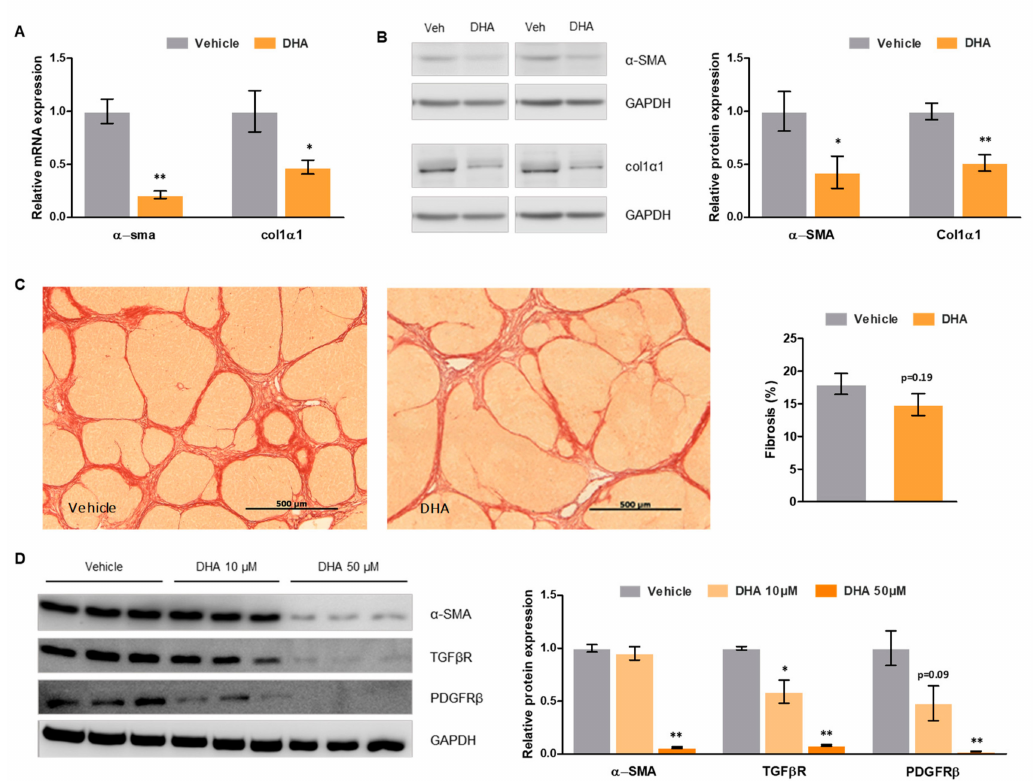
Figure 3. E ff ects of DHA on hepatic stellate cell (HSC) phenotype and fibrosis. ( A ) α -SMA and collagen-1 α 1 relative mRNA expression in total liver tissue from cirrhotic rats treated with DHA or vehicle, normalized to GAPDH. ( B ) α -SMA and collagen-1 α 1 relative protein expression in total liver tissue from cirrhotic rats treated with DHA or vehicle, normalized to GAPDH. ( C ) Representative images of Sirius Red staining of liver tissue sections from cirrhotic rats treated with DHA or vehicle (left—scale bar represents 500 µ m), and corresponding quantification (right). ( D ) α -SMA, TGF β R and PDGF β R relative protein expression in LX-2 HSCs treated with DHA (10 and 50 µ M) or vehicle, normalized to GAPDH. Results are expressed as mean ± S.E.M. * p < 0.05 and ** p < 0.01 vs. vehicle. n = 10 per group ( A – C ), and n = 3 per group ( D